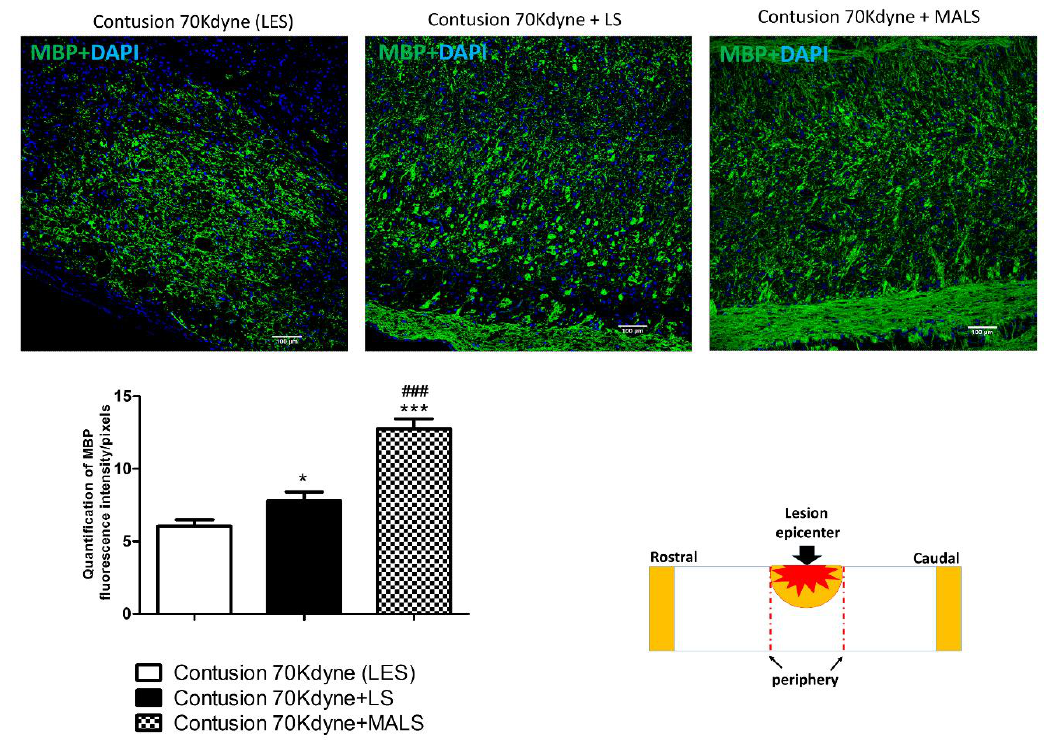
Figure 3. Protective action of MALS on myelin sparing in the injured cord. The image shows the protective action of MALS tissue in the epicenter of the injured cord (please see schematic representation). After animal perfusion, spinal cords were dissected, postfixed, and longitudinally sectioned by means of a cryostat. Spinal cord tissue sections were stained for myelin basic protein (MBP, green). The confocal microscope images for the spinal cord of lesioned animals and transplanted with LS or MALS tissue were obtained using the same intensity, pinhole, wavelength, and thickness of the acquisition. Scale bar: 100 µ m. The graph reported shows the quantification of fluorescence with reference to MBP staining. Data is expressed as mean of twelve di ff erent fields (n = 4 mice; 3 fields / mouse for each condition). Values represent mean ± SD. We determined the statistical di ff erences by means of one-way ANOVA test followed by Bonferroni’s post-test. *** p < 0.001; * p < 0.05 vs. LES; ### p < 0.001 vs. LS.